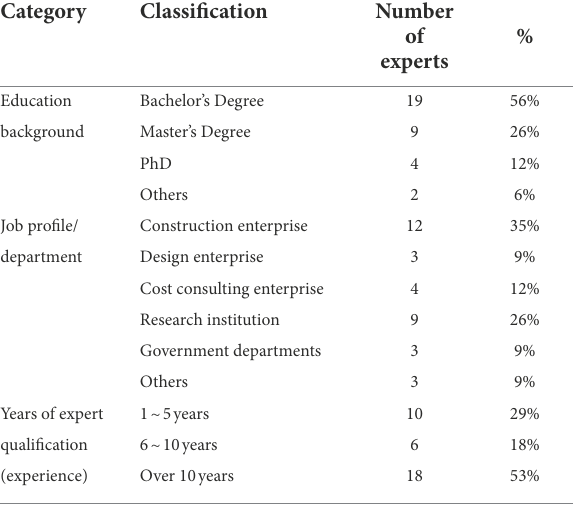
TABLE 2 Background profiles of interviewed